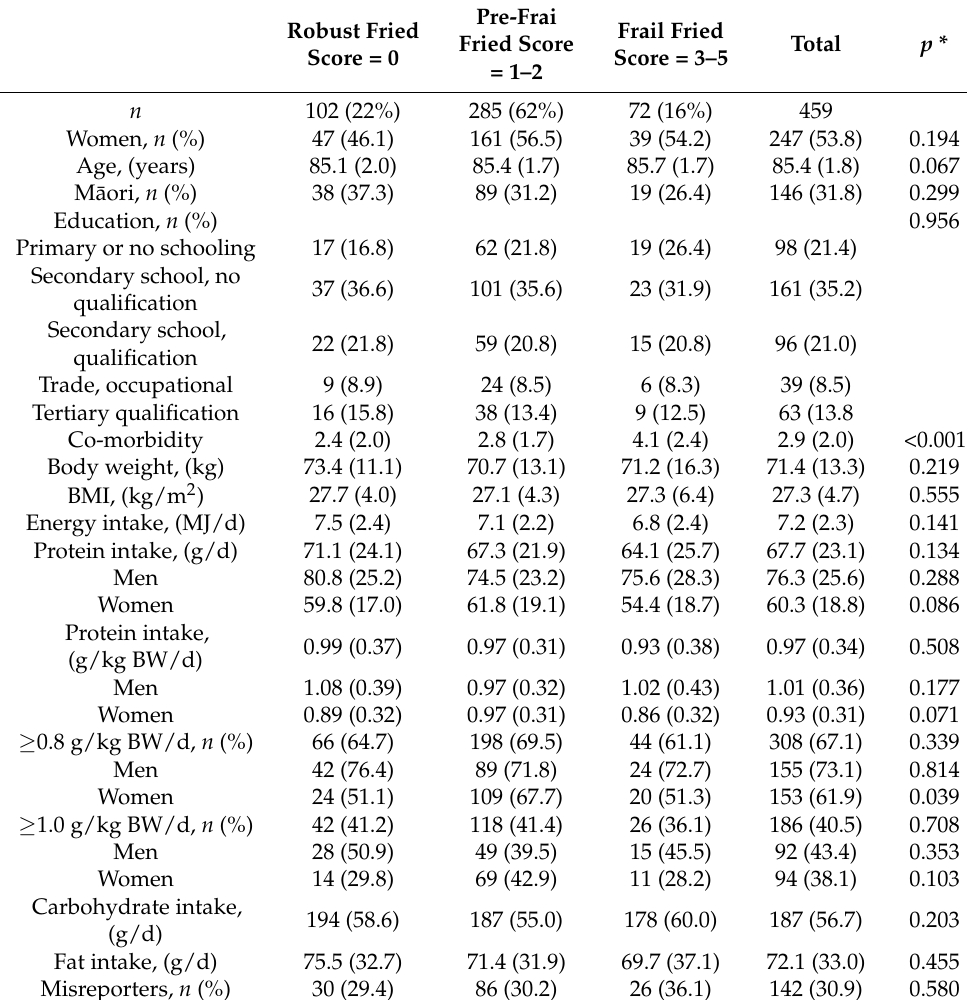
Table 1. Health and sociodemographic characteristics of 459 robust, pre-frail and frail LiLACS NZ participants at baseline (wave